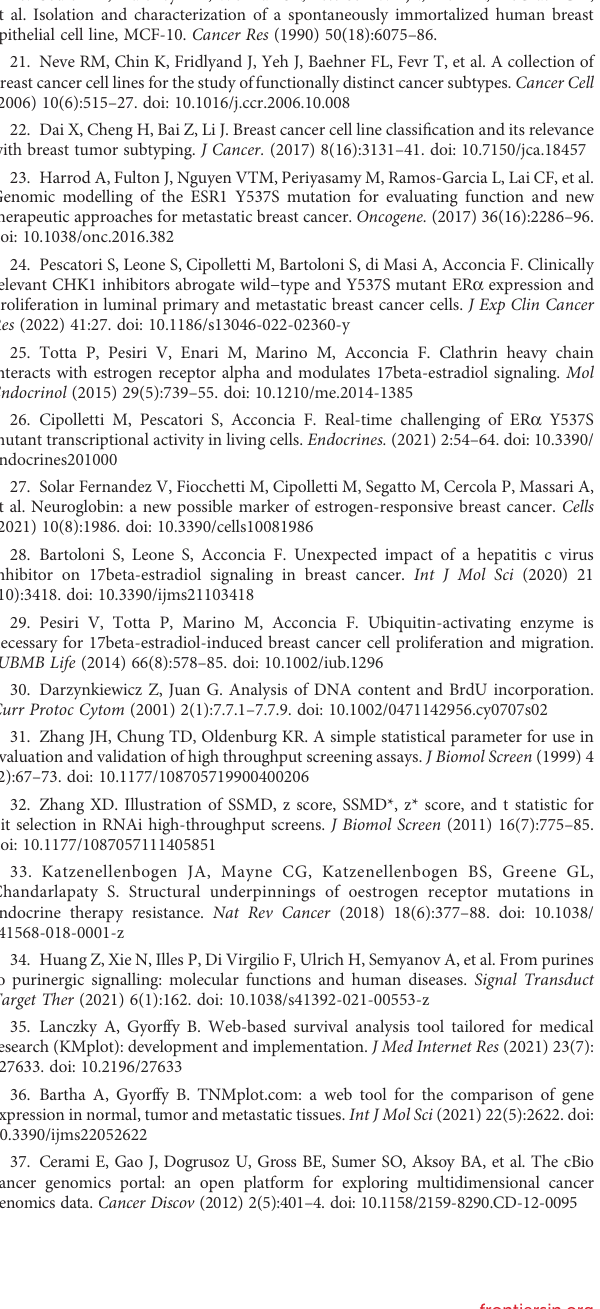
0.0001), *** (p value < 0.001), ** (p value < 0.01) and * (p value < 0.05) indicate signi fi cant differences with respect to untreated Y537S samples (panel A and B) or untreated (i.e., 0) sample (C). SUPPLEMENTARY FIGURE 5 4OH-Tamoxifen anti-proliferative effects in different BC cell lines. (A) Growth curve analyses in the indicated cell lines treated with the indicated doses of 4OH-Tamoxifen (Tam) for 12 days. (B) Linear regression and Spearman Correlation values between the sensitivity to Tam-induced anti-proliferative effect as downloaded by the DepMap portal (https://depmap.org/portal) and the calculated -Log2 transformed inhibitor concentration 50 (IC50) for Tam effects in the same BC cell lines. r and p-values are given in the main